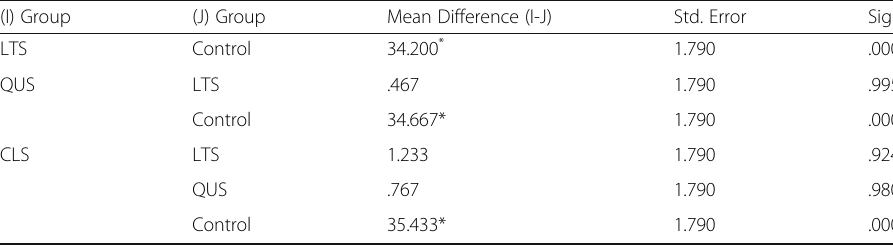
Table 8 Multiple Comparisons; Post-test of Level of Autonomy by Groups (I)